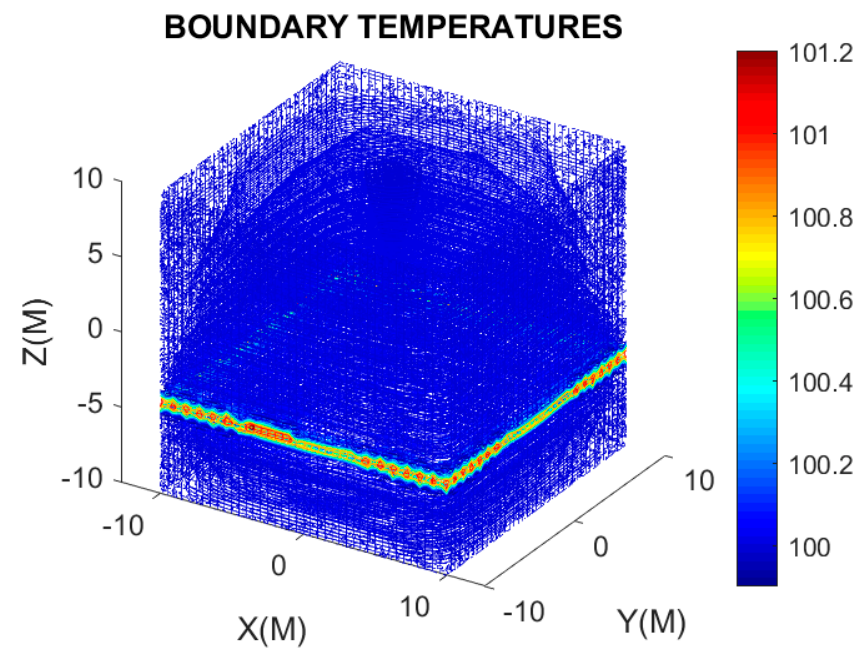
Figure 7. Model crustal volume external boundary temperature distribution over wellbore-centric computational volume for 0.6 m-thick isolated fracture-connectivity percolation fluid flow horizon that intersects an internal vertical wellbore. The existence of such isolated fracture-connectivity percolation fluid flow structures in the ambient crust is a consequence of the crustal rock-fluid interaction empirics (I)–(III) given in the introduction. Following Figure 5, the model volume is 20 m on a side and with an embedded central vertical wellbore. By model hypothesis, the crustal volume is at a constant ambient fluid pressure and temperature (nominally 100 °C), with the interior wellbore at lower fluid pressure and temperature. A horizonal crustal section of elevated poro-connectivity permeability κ (x,y,z) ~ exp( αφ (x,y,z)) feeds fluid of incrementally higher temperature through the model volume into the wellbore. The elevated model boundary temperature is fixed at nominal 1 °C above the ambient temperature. Steady-state fluid inflow from the crust at incremented boundary temperature transports heat to the wellbore, creating a localized temperature deviation from the ambient wellbore temperature. With these boundary conditions, the steady-state finite-element solver (7) generates a 3D temperature field that obeys the conservation of energy constraint Equation (4). The model axial temperature distribution at the central wellbore is compared to OTN1 temperature profiles in Figure 2. The resulting 3D temperature field is nominally a series of radially symmetric wellbore-centric temperature distributions that vary as a function of depth along the wellbore. The finite-element model 2D approximations to wellbore-centric temperature distributions can be compared with the analytic solution (5) for strictly 2D wellbore-centric flow characterized by Peclet number P e = r 0 φ v 0 /D. The scalar field variables represented by finite element scale field u(x,y,z) are, for (6), pressure P(x,y,z), for solving the Darcy flow constraint Equation (2), and for (7), temperature T(x,y,z), for solving the thermal energy constraint Equation (4). For pressure fields u = P(x,y,z), (6) is